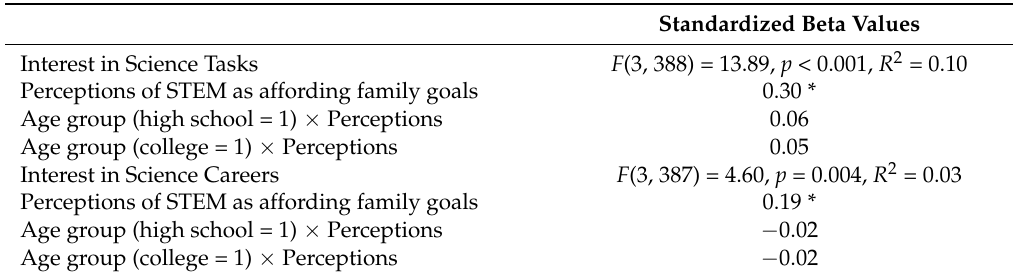
Table 2. Study 1: Predictors of Interest in STEM Careers and